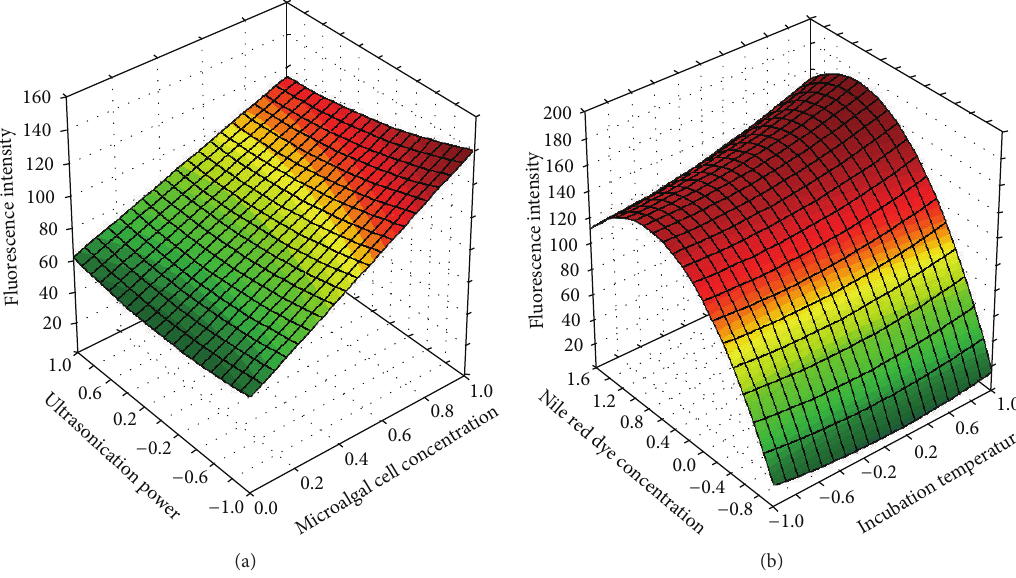
Figure 5: 3D response surface plots of fluorescence intensity as predicted by the quadratic model. In each plot, the effects of two independent variables (in coded values) on fluorescence intensity are simultaneously demonstrated. For each surface plot, the other independent variables which do not form the plot axes are fixed (in coded values): (a) incubation temperature = 0, Nile red dye concentration = 0; (b) microalgal cell concentration = 1, ultrasonication power = 0. Excitation wavelength = 530 nm, emission wavelength = 607 nm, and poststaining time =